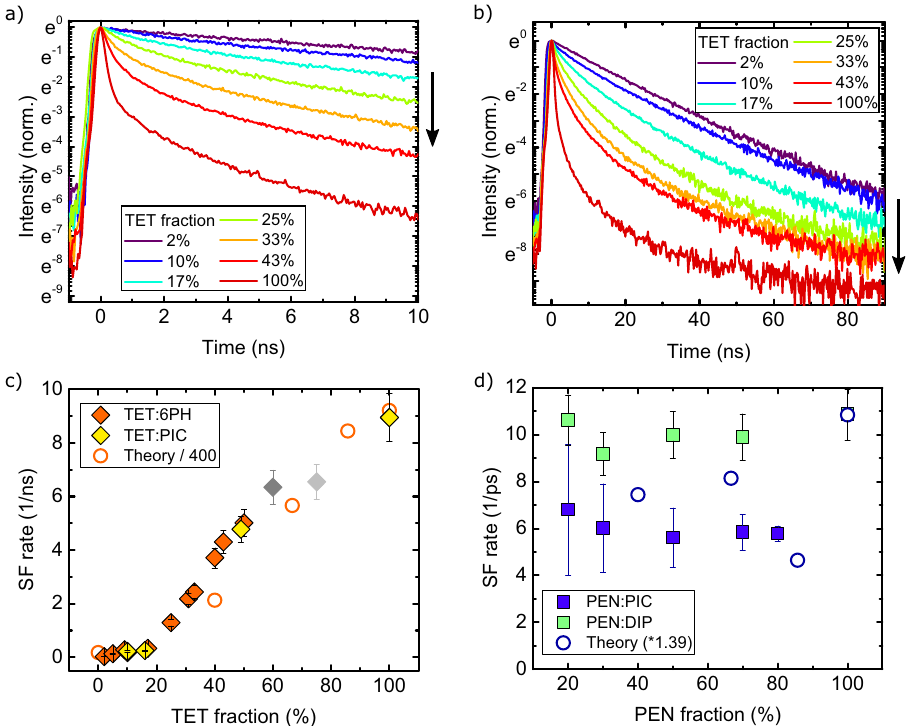
Fig. 2 Time-resolved photoluminescence (TRPL) measurements and comparison of measured and calculated SF rates. a TRPL intensity of TET:6PH blends with different TET fractions in a 10-ns window. b Equivalent to a but in a 90-ns window. The arrows in a and b denote the direction of increasing TET fraction. c , d Comparison of experimentally ( fi lled symbols) and theoretically (open circles) determined SF rate constants for TET- and PEN-based 41 blends with varying concentrations of spacer molecules or the average number of nearest neighbours (NN). The experimental SF rates of TET:6PH and TET:PIC blends in c have been obtained by subtracting the monomeric decay rate (determined by fi tting the 2% TET blend) from the decay rate of the prompt fl uorescence, as explained in the text. The grey data points correspond to TET fractions where a phase separation of TET crystallites sets in (dark grey: TET:6PH, light grey: TET:PIC). The experimental data of PEN blends in d are adapted from Ref. 41 . Error bars denote the 95% con fi dence interval of the fi